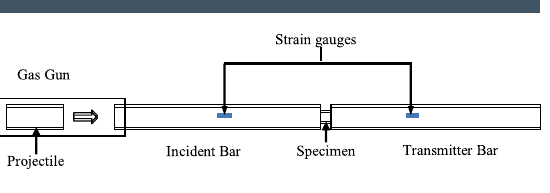
Figure 3. A typical SHPB system.